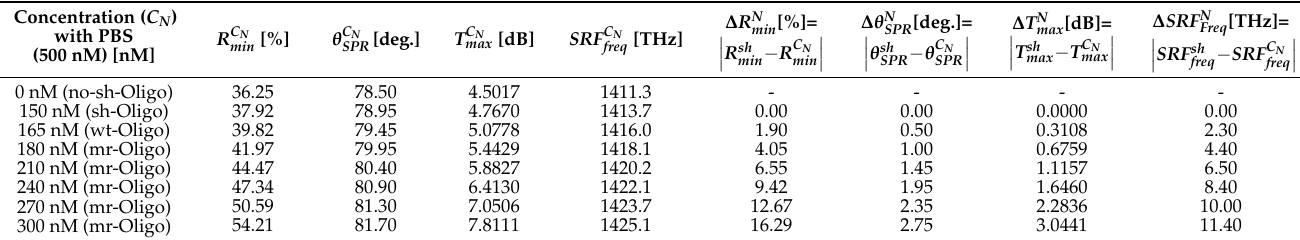
Table 8. R C N , θ C N , T C N max andSRF C N for different concentrations of the target oligonucleotides as an SPR min freq